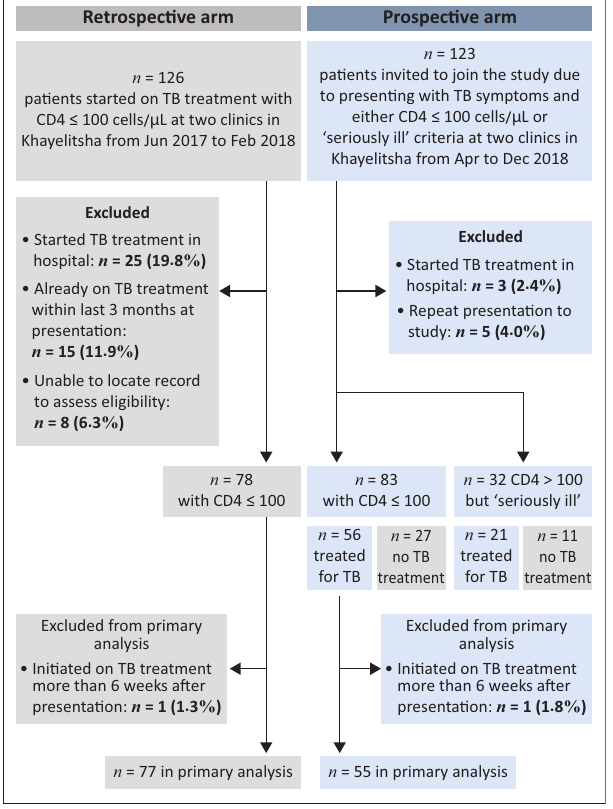
FIGURE 1: Flow diagram of